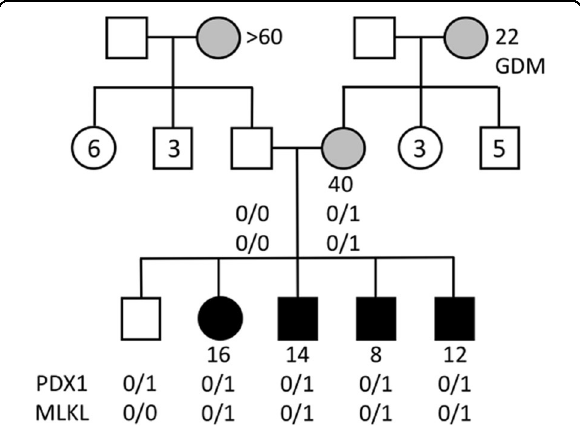
Fig. 1 Pedigree of a non-consanguineous Palestinian diabetic family. Gray- and black- fi lled shapes indicate mild and severe diabetes, respectively. White- fi lled shapes represent the unaffected family members; numbers inside shapes re fl ect the number of unaffected siblings. Circles represent females while squares represent males. Numbers stated beside circles and squares refer to age of disease onset. GDM is Gestational Diabetes Mellitus. Genotypes listed are for PDX1 and MLKL mutations